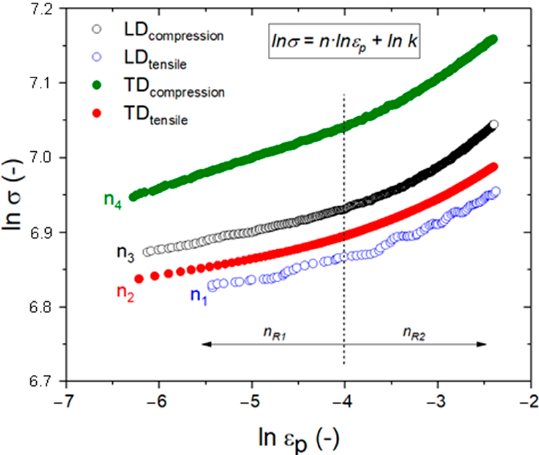
Figure 5. Log-log representation of true stress (ln σ ) and true plastic strain (ln ε p ). Range of interest: 0% ≤ ε p ≤ 9%. Table 3. Summary of the strain-hardening exponents of the power law relationship determined in both regions with their respective fitting coefficients R 2 . n R1 and n R2 denote the n exponent for each region present in Figure 5. Loading Stress